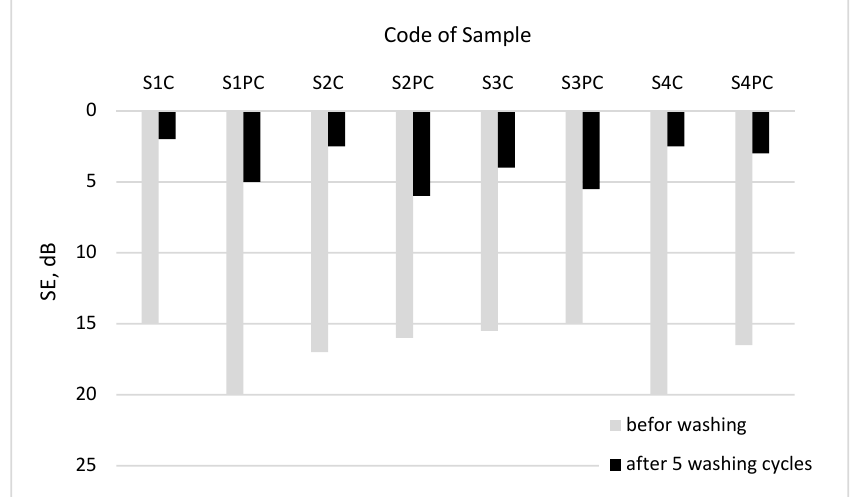
Figure 10. Influence of plasma treatment of shielding effectiveness before and after washing procedure. Figure 11. An appearance of coated side of fabric after washing procedures.